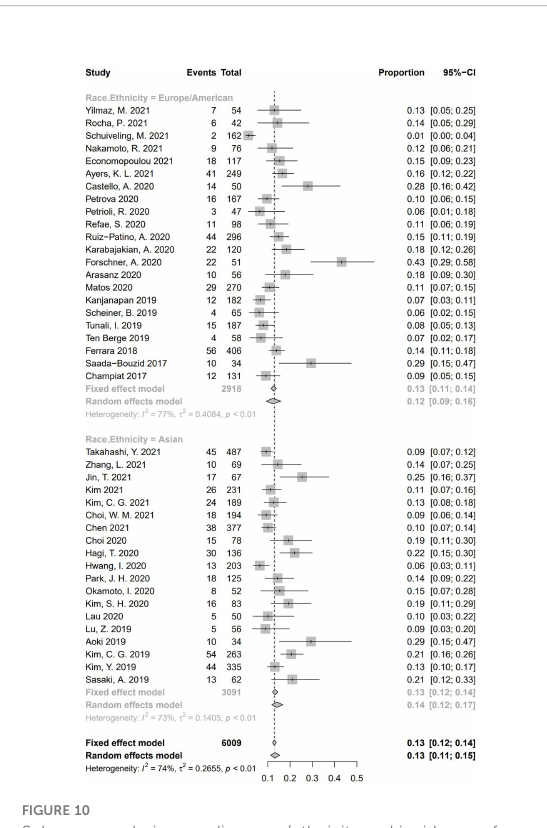
FIGURE 11 Subgroup analysis regarding gender ratio (male:female) and incidence of hyperprogressive disease. CI, con fi dence